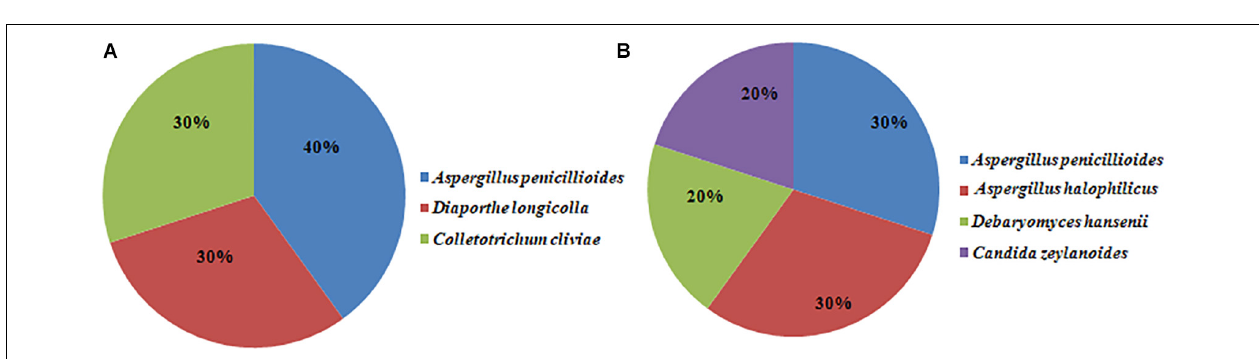
FIGURE 9 | Fungal strains composition in spicy (A) and spiced (B) Doushen